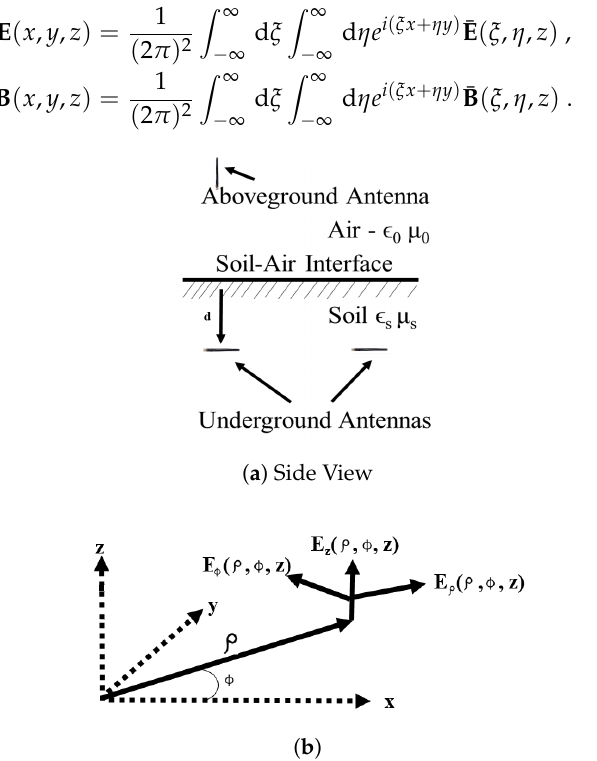
Figure 1. The drawing of the geometry of the underground antenna in the soil propagation medium: ( a ) schematic; ( b ) coordinate